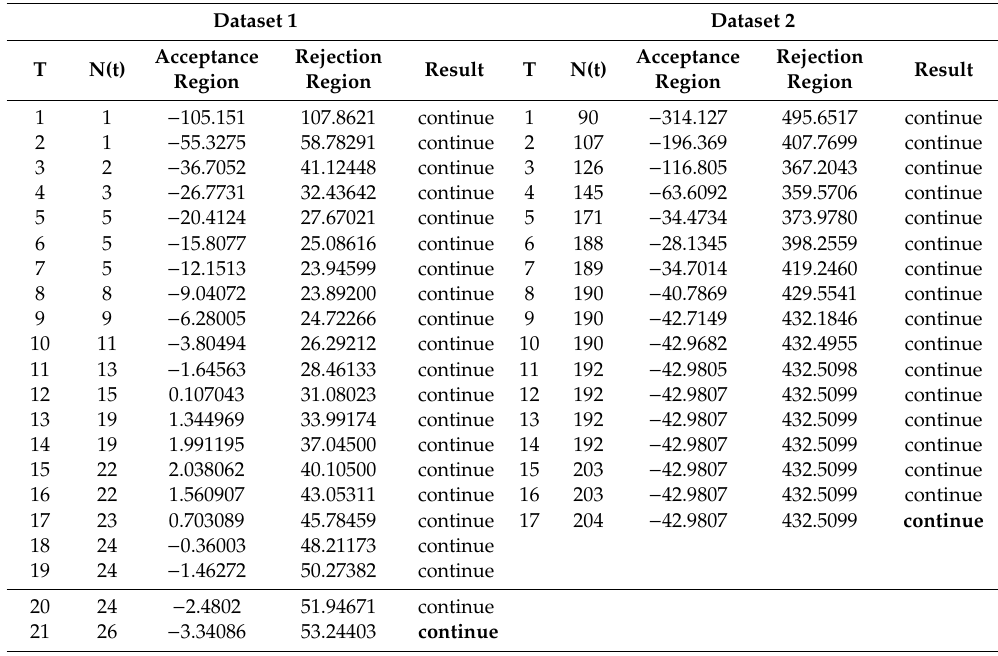
Table 10. SPRT results for both datasets (Case 1, parameter